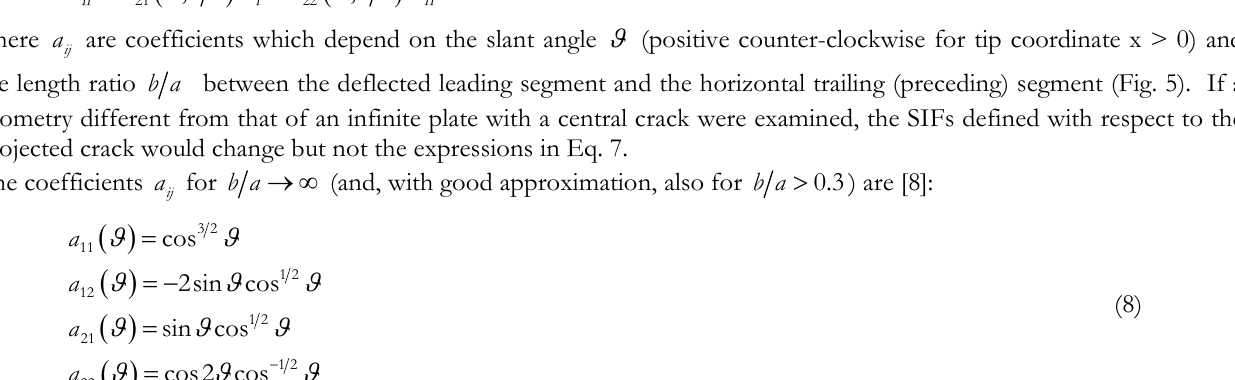
Figure 6: Infinite cracked plane with an inclined crack under remote tensile stress